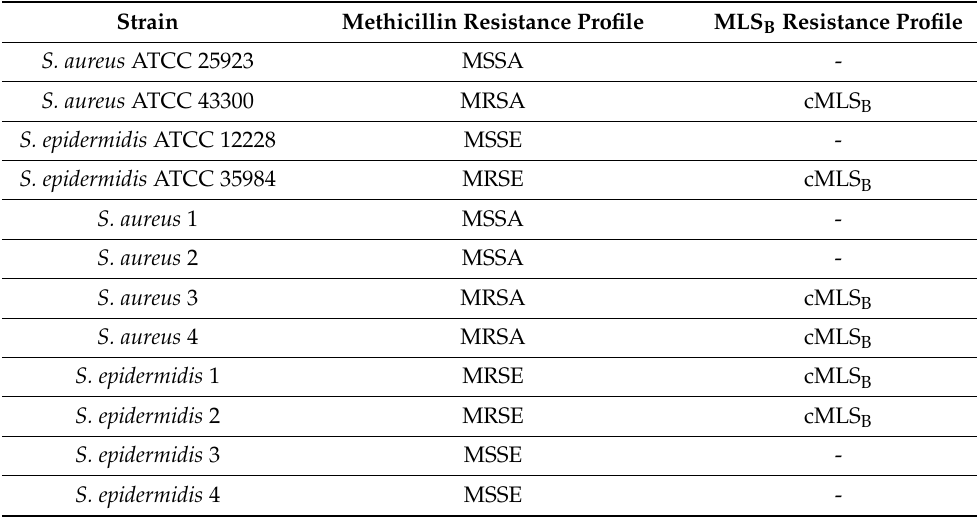
Table 1. The methicillin and MLS B resistance profiles of examined strains. Strain Methicillin Resistance